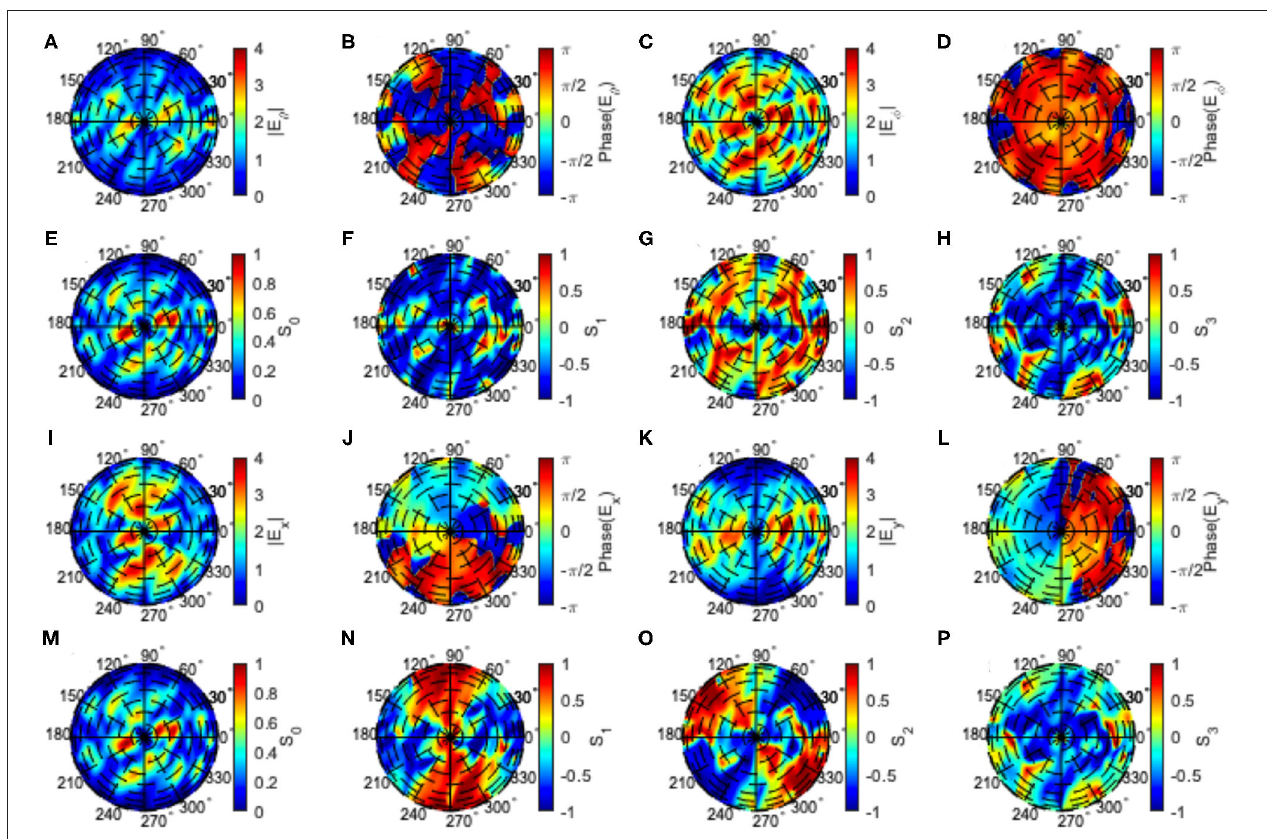
FIGURE 8 | Far-fields and Stokes parameters of left vortex from the gear of N 10. The input port 1 is used to inject photons to the waveguide. Far-fields and Stokes = parameters are shown (A–H) in a polar coordinate ( r , θ , φ ) and (I–P) in a cylindrical coordinate ( r , φ , z ). The ring-shape of the mode in the near-field could not be sustained in far-fields (A,C,E,I) , because our mode is not collimated. Consequently, the vortex is not well-defined in far-fields, while the phase is still rotated over the hemisphere (J,L) , reflecting the original nature of a left-vortexed state. The polarization is also dominated by the right-circularly polarized component (H,P) with S 3 1 for the high intensity ∼ −